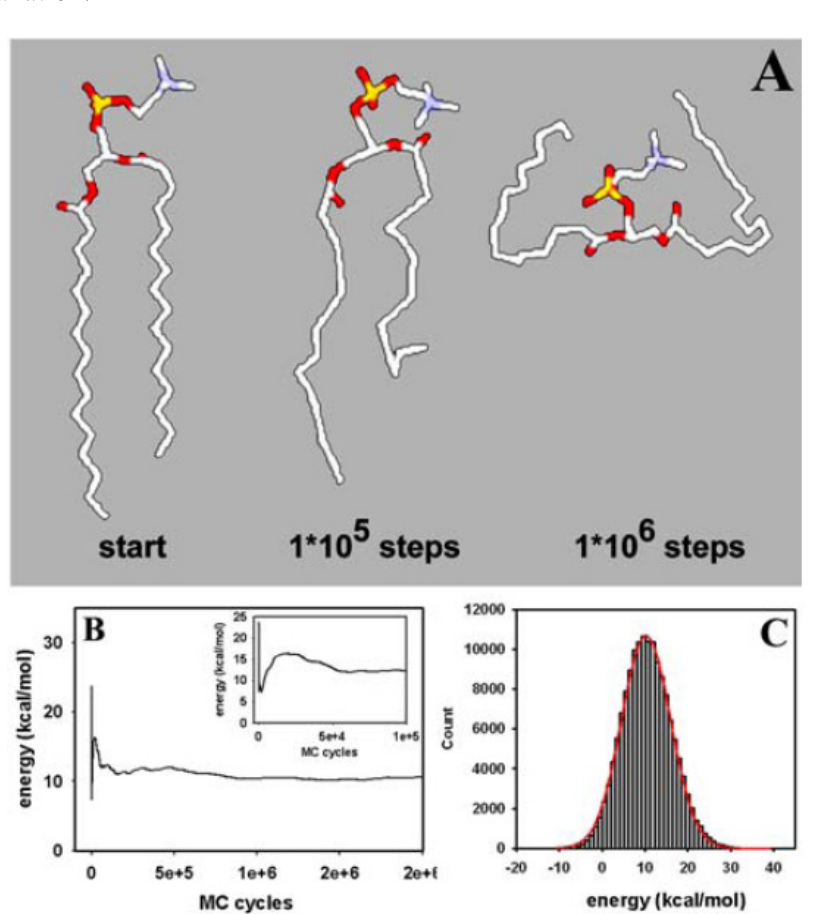
Figure 2. Snapshot and energy of a single-molecule Monte Carlo simulation. ( A ) starting conformation (start) and representative snapshots of a single molecule MC simulation are shown after 1·× 10 5 and 1·× 10 6 MC steps. Large conformational moves of the fatty acyl chains and the lipid head group can be observed; ( B ) mean system energy equivalent to the conformational energy calculated from the AMBER force field during the simulation [85]. The conformational energy becomes stable already after about 750,000 MC steps. The inset shows the initial phase of energy equilibration with a maximum after about 20,000 MC steps; ( C ) histogram of the conformational energy of the last one million MC steps (grey bars) overlaid with a fit to a Gaussian function of the form ( ) 2 )2)((exp)( σ⋅−⋅= EEAEf providing the mean energy at equilibrium, E , and the standard deviation, σ , as a measure of fluctuations around the mean value (red line). See text for further explanation.